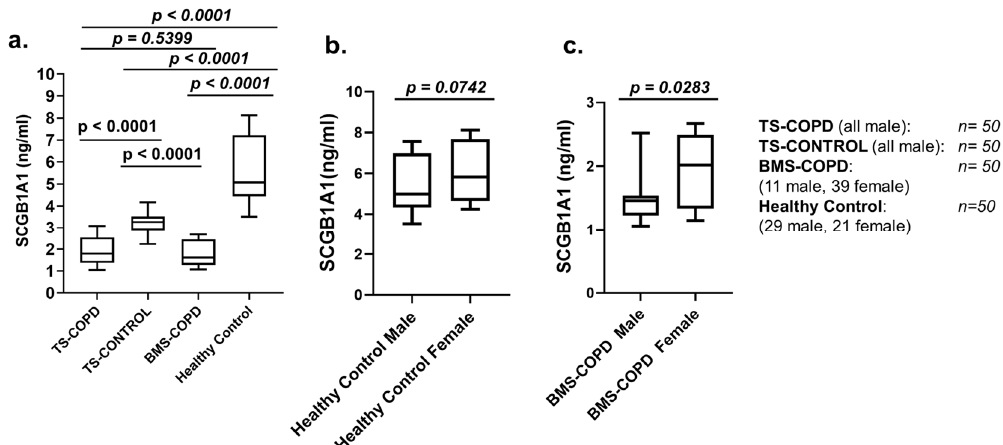
Figure 2. Serum concentrations of secretoglobin family 1A member 1 (SCGB1A1) among: ( a ) tobacco smokers with chronic obstructive pulmonary disease (TS-COPD), tobacco smokers without COPD (TS-CONTROL; asymptomatic smokers), biomass smoke induced COPD (BMS-COPD), and healthy control subjects ( n = 50 subjects/group). ( b ) SCGB1A1 levels were similar among male and female healthy control subjects. ( c ) Slightly higher SCGB1A1 levels were detected among female BMS-COPD subjects compared to male BMS-COPD subjects. Data are presented as median (25th–75th percentile) and range. Statistical analysis was performed using the non-parametric Kruskal–Wallis followed by Mann–Whitney U tests (two tailed), when appropriate. p < 0.05 was considered as statistically